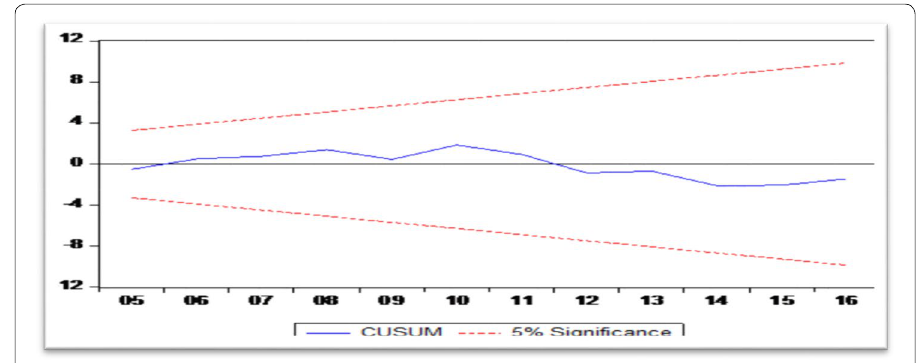
Fig. 4 Plot of the cumulative sum of recursive residuals